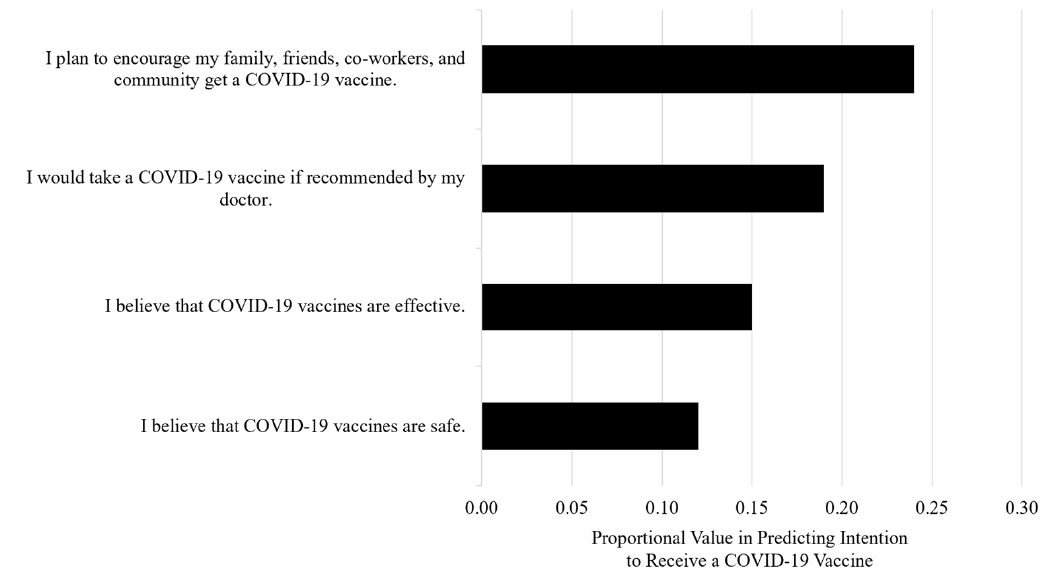
Figure 3. Predictors of the intention to receive a COVID-19 vaccine. Levels of model importance in predicting the intention to receive a COVID-19 vaccine based on webinar participant demographics and beliefs.